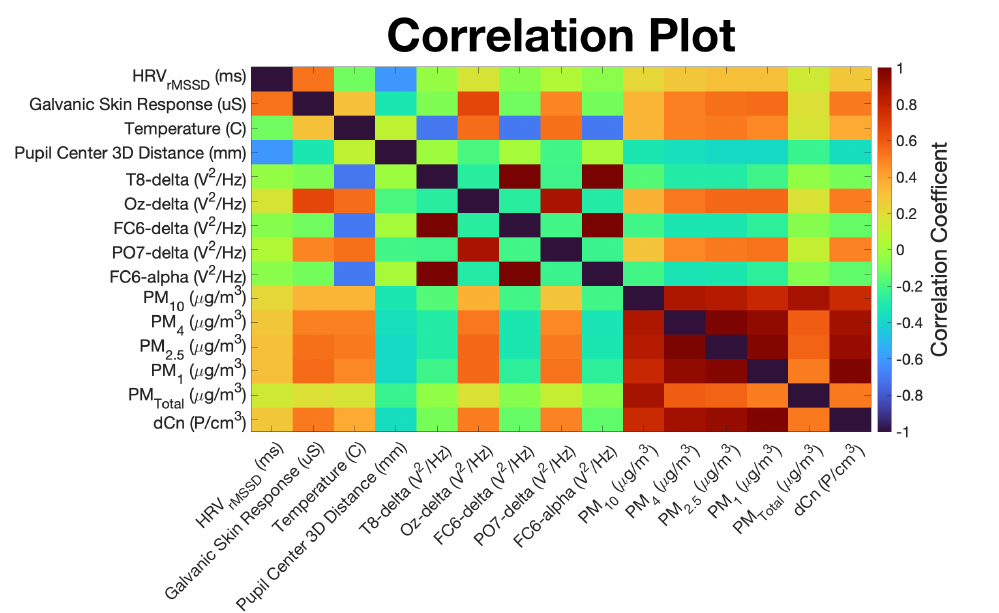
Figure 7. Correlation plot of top 9 EEG and non-EEG biometric predictor variables, along with 6 target PM variables. Positively correlated variable pairs are indicated by a red box, negatively correlated pairs are shown by blue boxes, and non-correlated pairs have green boxes.